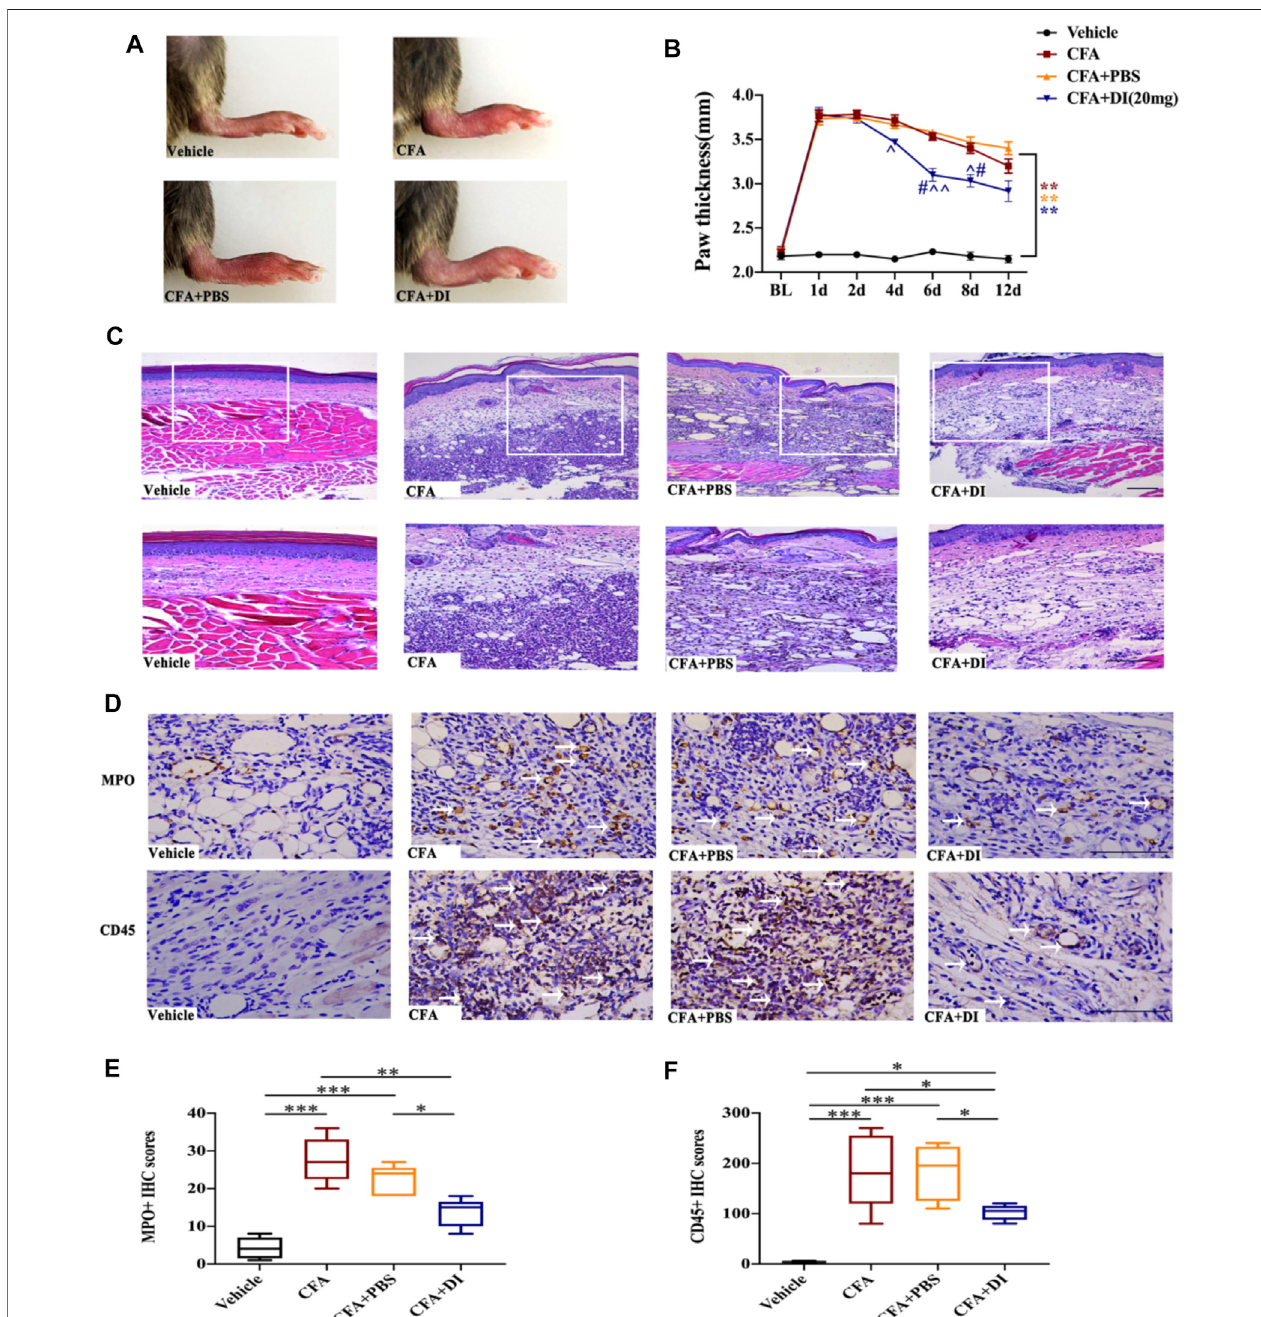
FIGURE3| EffectofDIonpawthicknessandIn fl ammatorycellin fi ltrationinCFAmodel. (A) Macroscopicimagesofhindpawderivedfromvehicle,CFAandCFA+ PBS and CFA + DI-treated mice. (B) Hind paw thickness (mm) as a function of time (days) was measured in each group. F group (18, 105) = 22.88 for (B) (N = 6 mice/ group). (C) HE staining. In fl ammation with abundant lymphocytes and sparse neutrophilic granulocytes in a CFA mouse with hypodermic injection and low-grade in fl ammationinaCFAmousewithahypodermicinjectionofDI(20 mg).Thisexperimentwasrepeatedindependently3timesandsimilarresultswereobtained.The scale bar represents 200 and 100 μ m. (D) Photomicrographs representing MPO and CD45 immunoreactivity in each group. Arrowheads indicate positive cells. ** p < 0.01 versus the vehicle group; # p < 0.05 versus the CFA group; ˄ p < 0.05, ˄˄ p < 0.01 versus the CFA + PBS group. (E,F) MPO score and CD45 score. F group (3, 16) = 16.68 for (E) , F group (3, 16) = 28.36 for (F) . The scale bar represents 50 μ m. This experiment was repeated independently 3 – 5 times and similar results were obtained. * p < 0.05, ** p < 0.01 and *** p < 0.001.